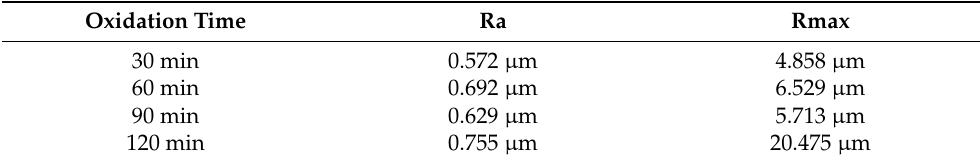
Table 7. Ra and Rmax values with different temperature.